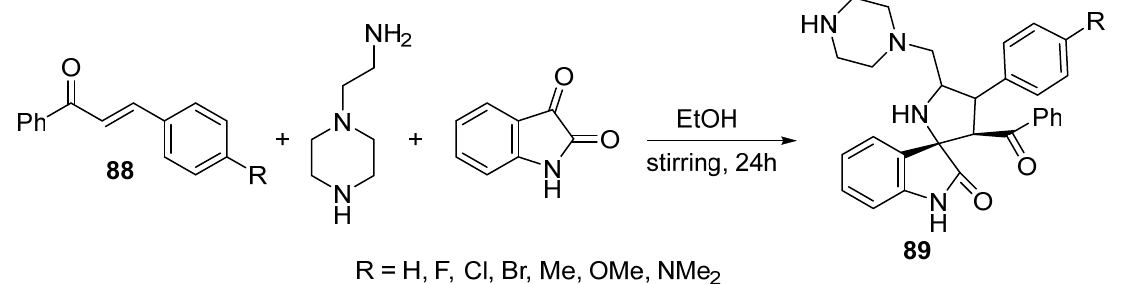
Scheme 27. Synthesis of spiro[indoline -3,2 (cid:48) -pyrrolidins] 89 .